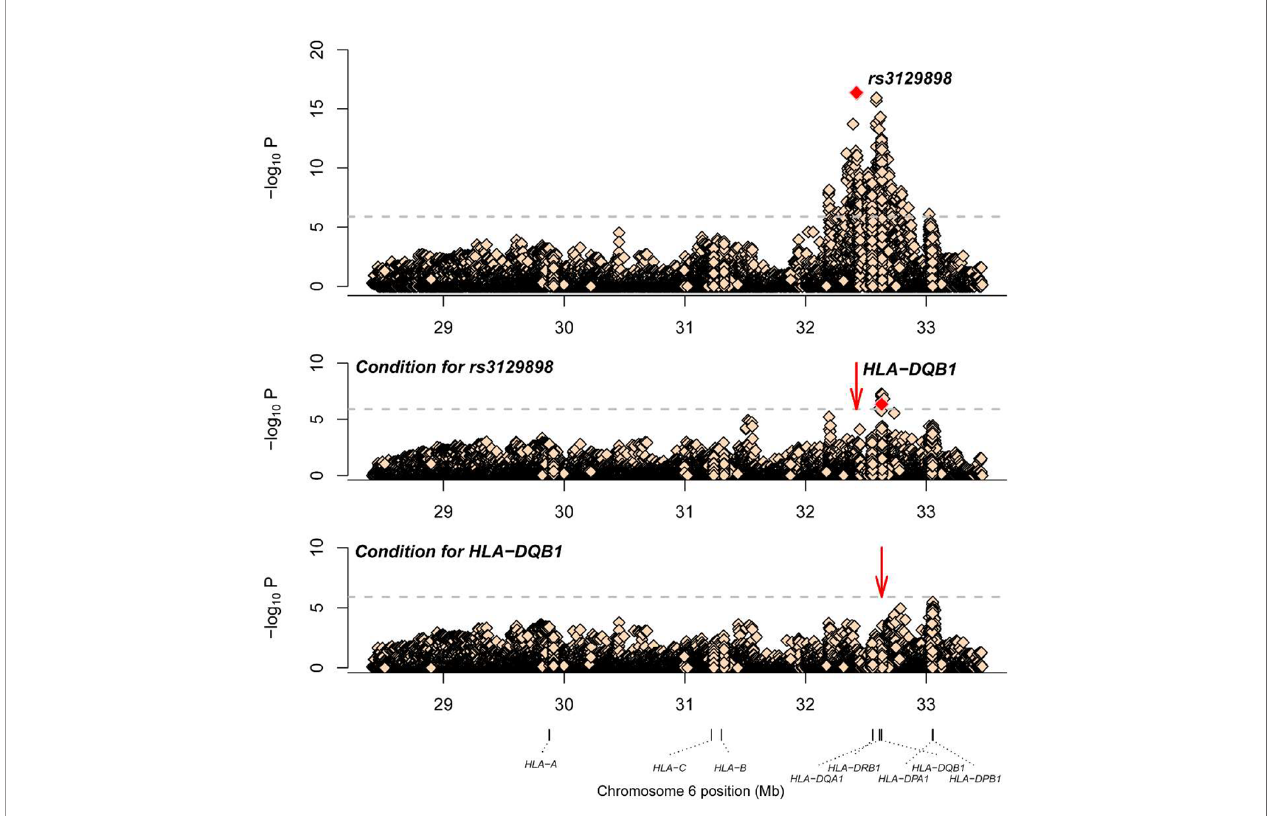
FIGURE 2 | Association plots of stepwise conditional analysis for HLA alleles and SNPs with SLE. The abscissa represents genomic loci, and the ordinate represents the -log10(p) of association analysis for each locus. The horizontal line represents the signi fi cance threshold P=1.25×10 – 6 . The dots marked red in each panel represent the points used for condition analysis (rs3129898 and